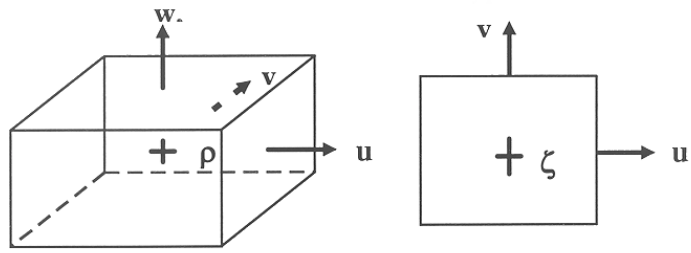
Figure 1. Arakawa C − grid (left side view; right top view).